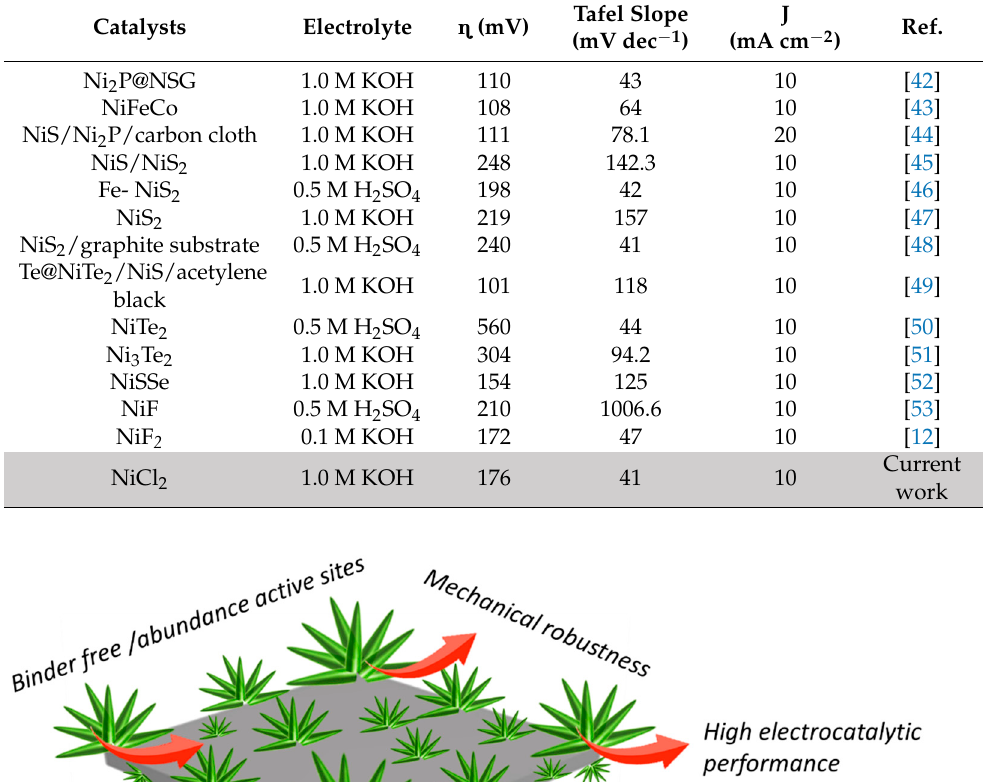
Table 1. The comparative set up showing HER activities of present work with reported data. Catalysts